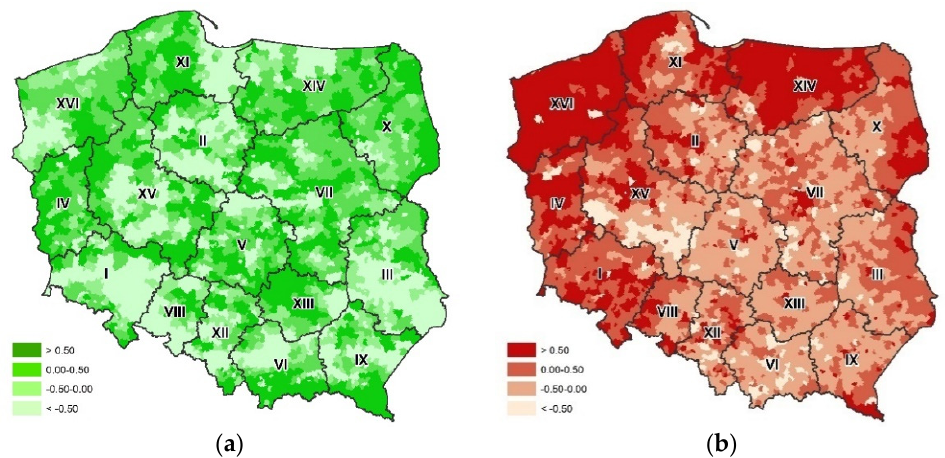
Figure 1. Environmental ( a ) and agricultural ( b ) determinants of green development of Polish agriculture. Voivodships are marked with digits: I—Lower Silesia, II—Kuyavia-Pomerania, III— Lublin, IV—Lubusz, V—Ł ó d´z, VI—Lesser Poland, VII—Masovia, VIII—Opole, IX—Subcarpathia, X—Podlasie, XI—Pomerania, XII—Silesia, XIII—Holy Cross, XIV—Warmia-Masuria, XV—Greater Poland, XVI—West Pomerania. Source: own